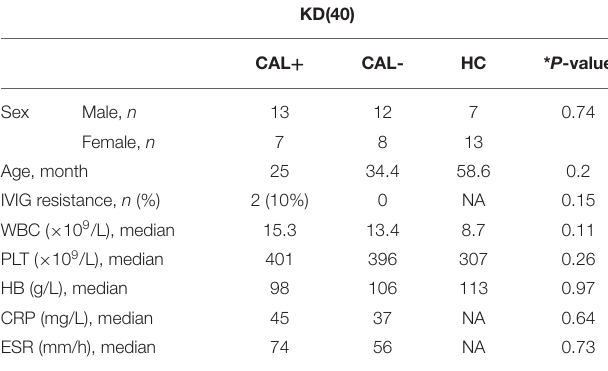
TABLE 1 | Characteristics of healthy controls and KD patients with different coronary artery